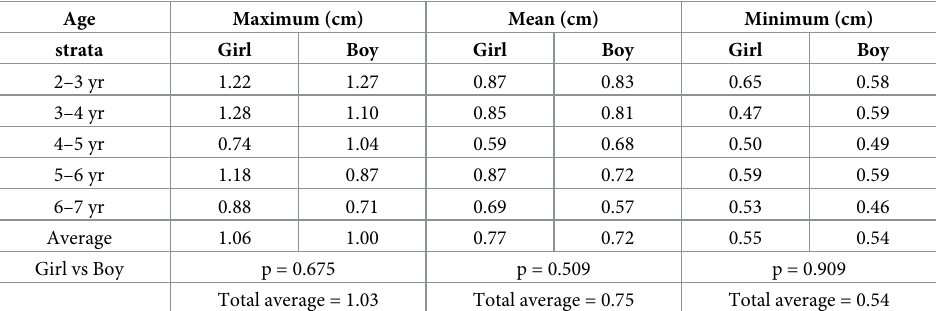
Table 4. Estimated values of the short-axis diameter intervals of the largest mesenteric lymph node according to fitting lines and reference intervals of lymphocyte